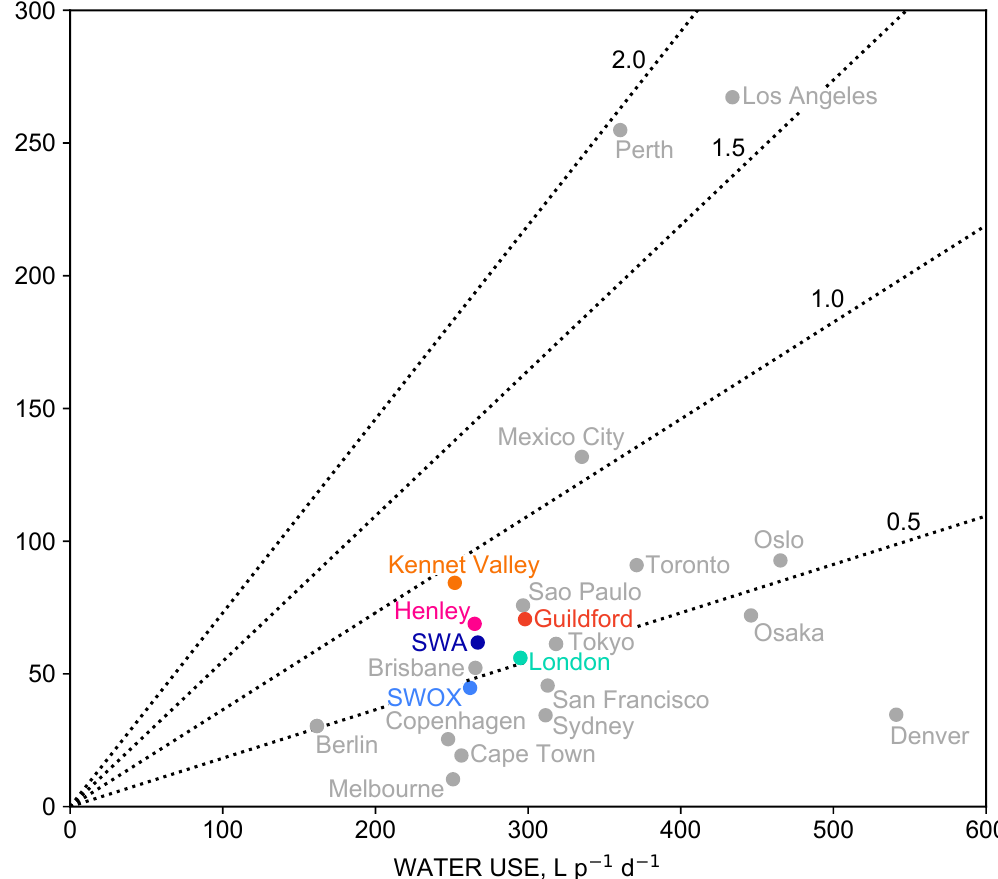
Figure 5. Water-related energy use (kWh p − 1 year − 1 ) against water use (L p − 1 day − 1 ) in the Thames Water Utilities Ltd. system in 2012 compared against other regions in the world (grey). The dotted lines are plotted for reference and indicate 0.5–2.0 kWh m − 3 energy intensities. Data for other regions were obtained from Lam et al.